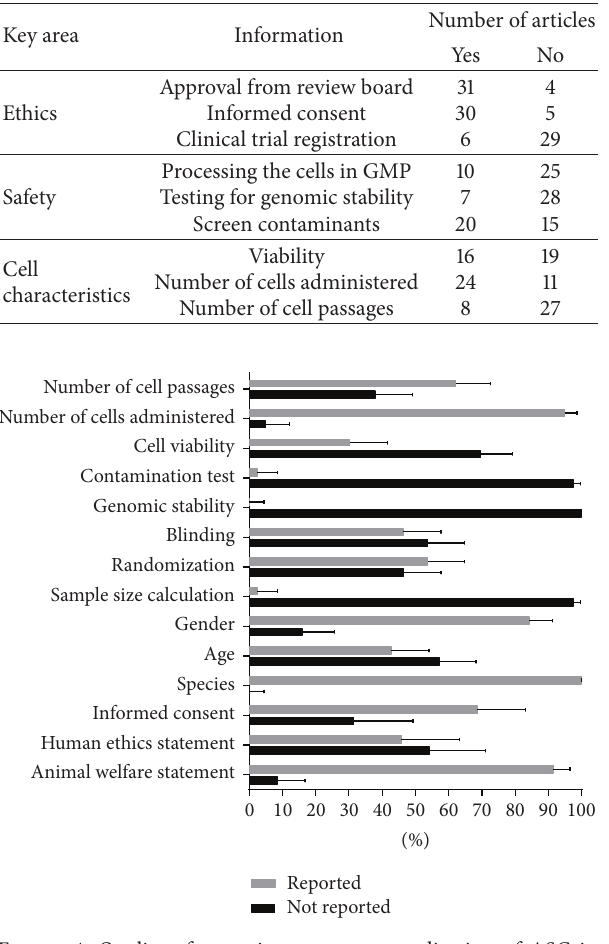
Figure 4: Quality of reporting papers on application of ASC in animals using selected parameters in ethics, safety, study design, and cell characteristics ( 𝑛 = 82